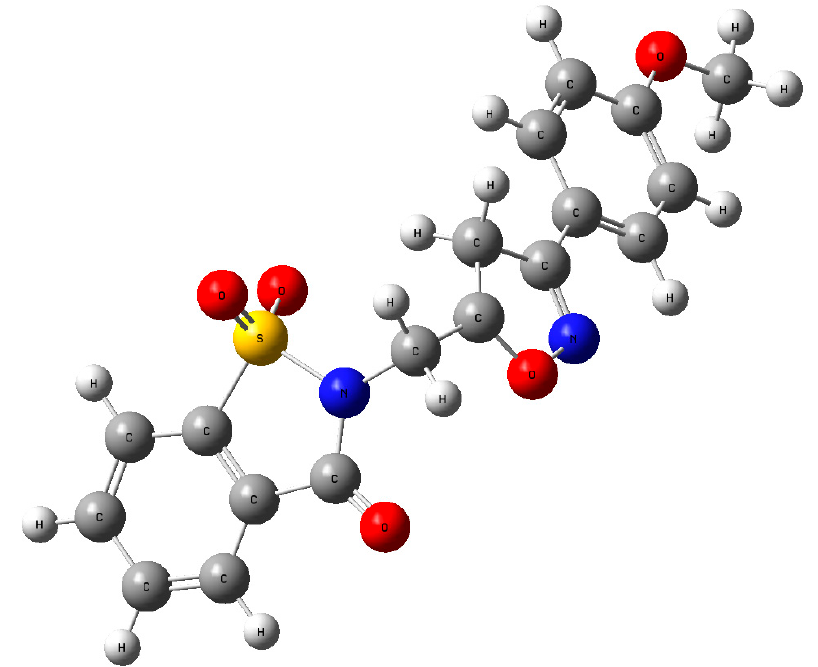
Figure 7. The optimized structure of title compound. Table 1. Comparison (X-ray and density functional theory) of selected bond lengths and angles (Å, °). X-ray